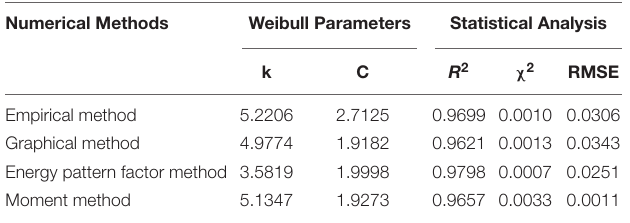
TABLE 4 | Weibull parameters and statistical test, year 2013.